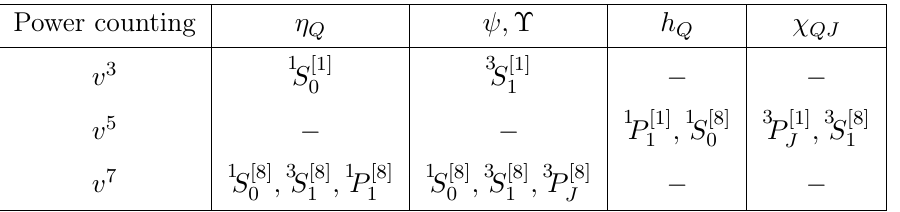
Table 1 . The leading power counting of various Fock states contributing to various quarkonium within NRQCD velocity scaling rule